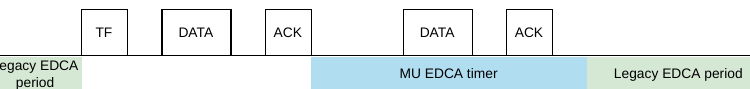
Figure 11. MU EDCA